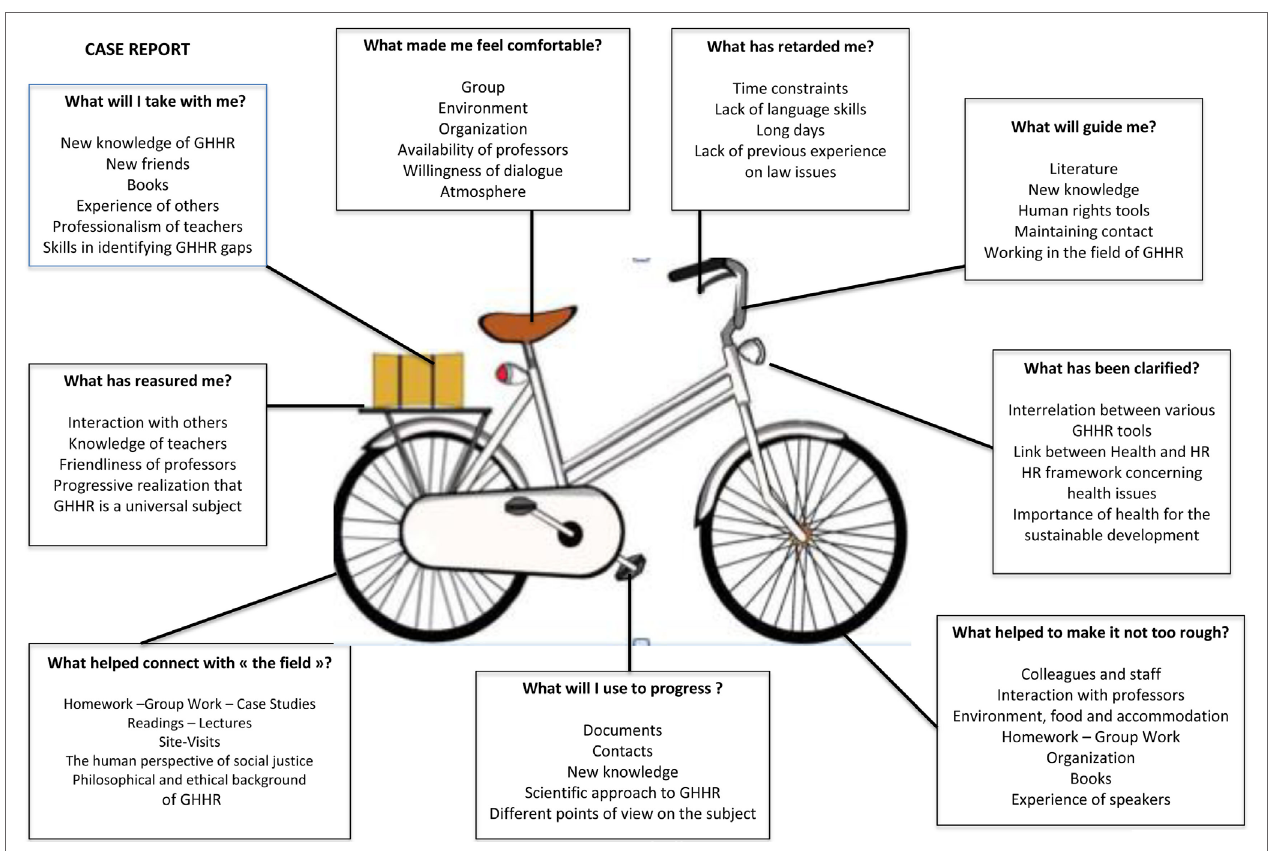
Figure 1 | Global evaluation from successive cohorts: “What is the contribution of the program to me personally?”